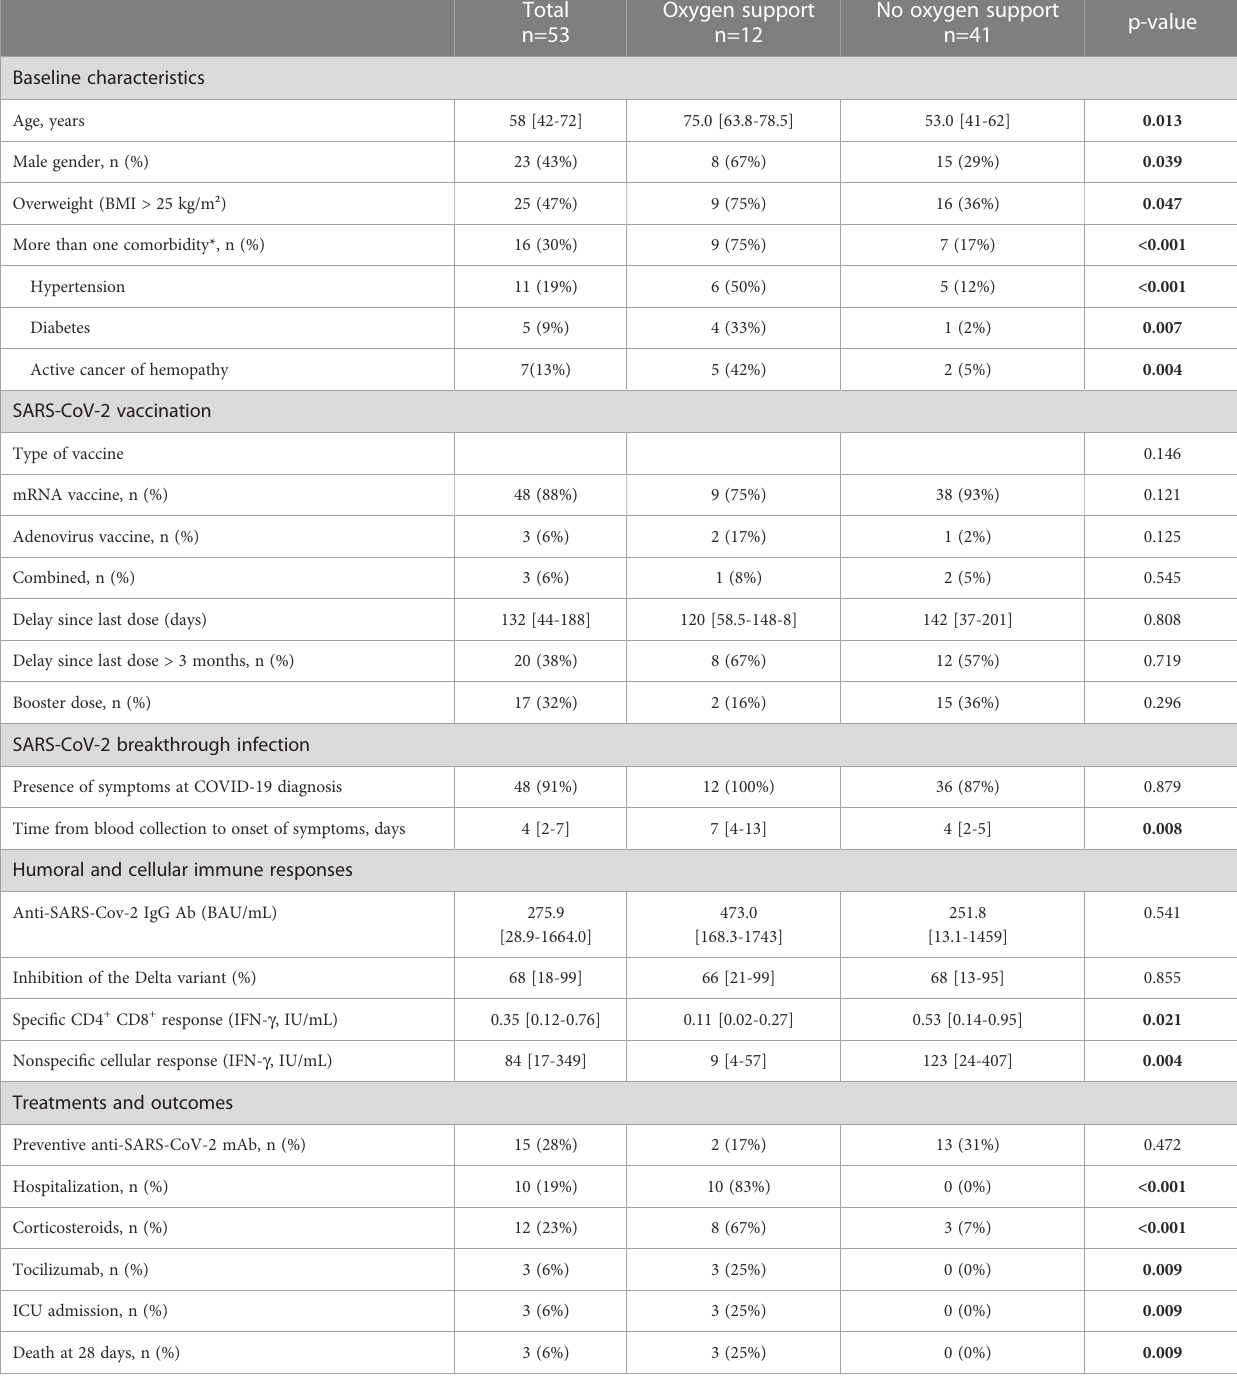
TABLE 1 Characteristics of patients and their post vaccination immune response according to oxygen